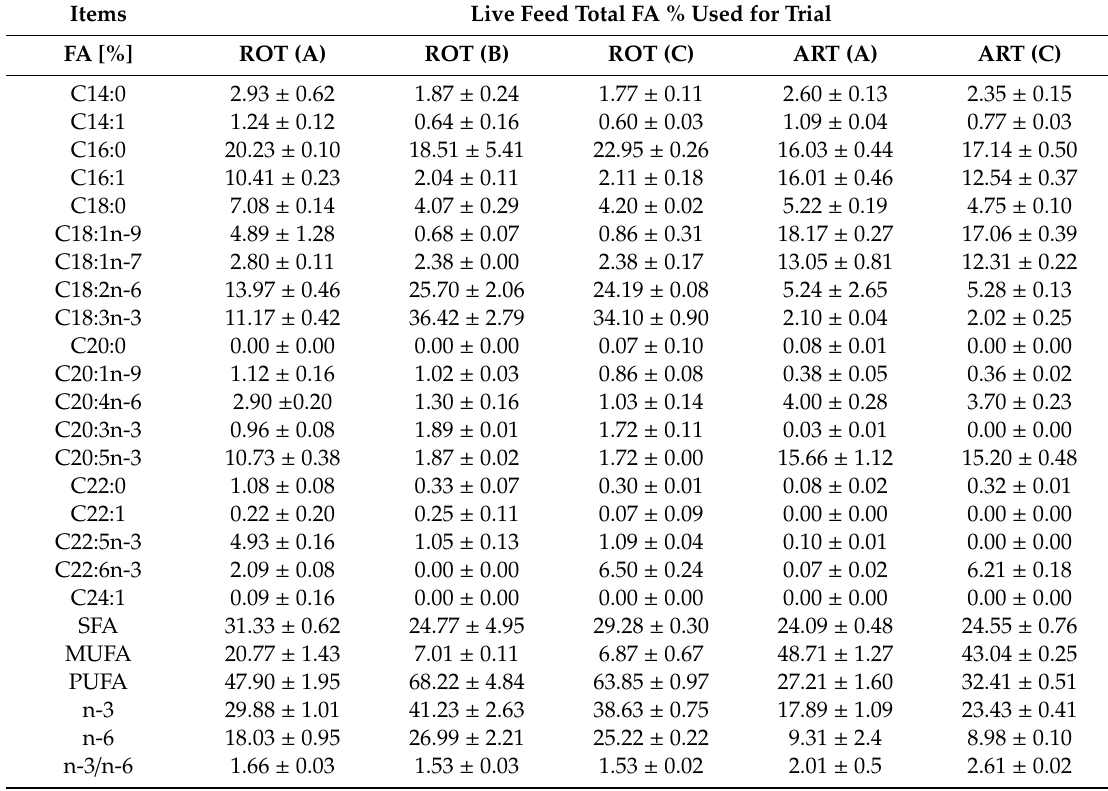
Table 1. Total fatty acids percentage composition and mean ( ± Standard deviation) from the live feed supplied to the larvae for the three